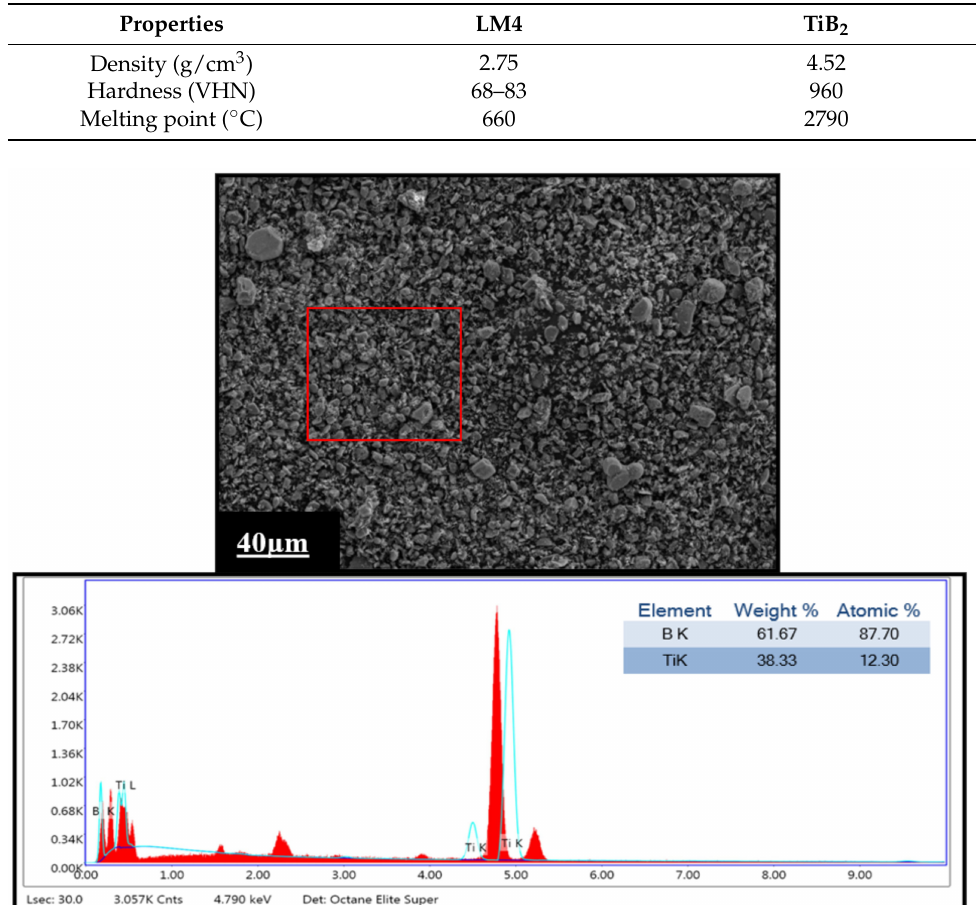
Table 2. Properties of LM4 alloy and TiB 2 reinforcement [4,19].